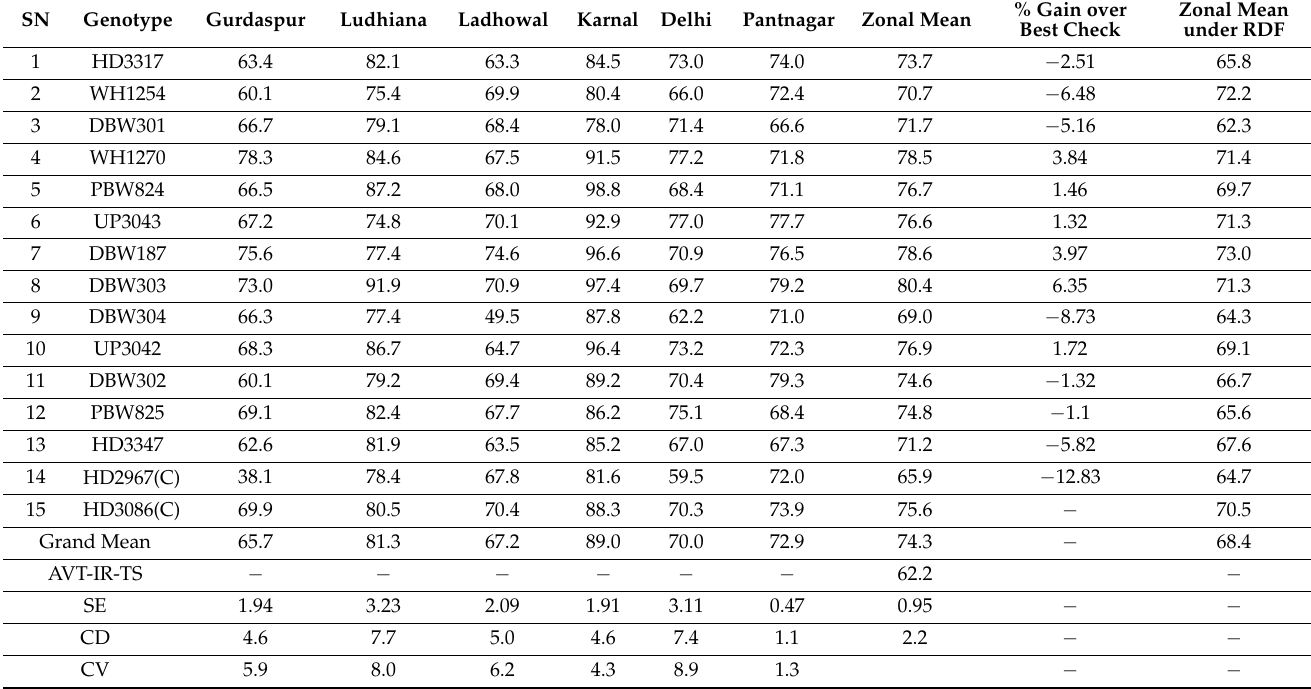
Table 1. Mean yield (q/ha) of HYPT trials at six locations during